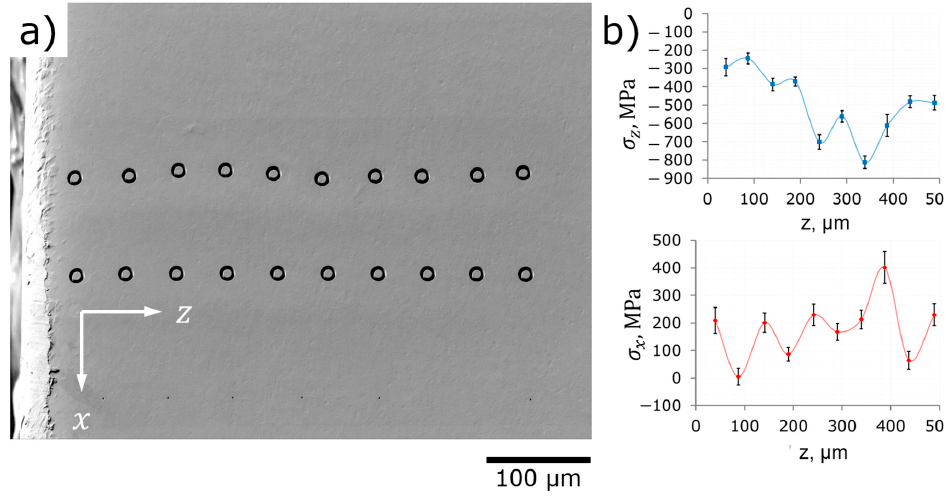
Figure 11 Figure 11. Depth distribution of RS in shot peened area (the edge of sample): ( a ) SEM image of probing FIB core-ring holes at Face II 5 × 3 mm 2 ; ( b ) profiles of σ x and σ z against depth. Subsurface σ x stress profile (in-plane stresses, parallel to shot peened surface) build